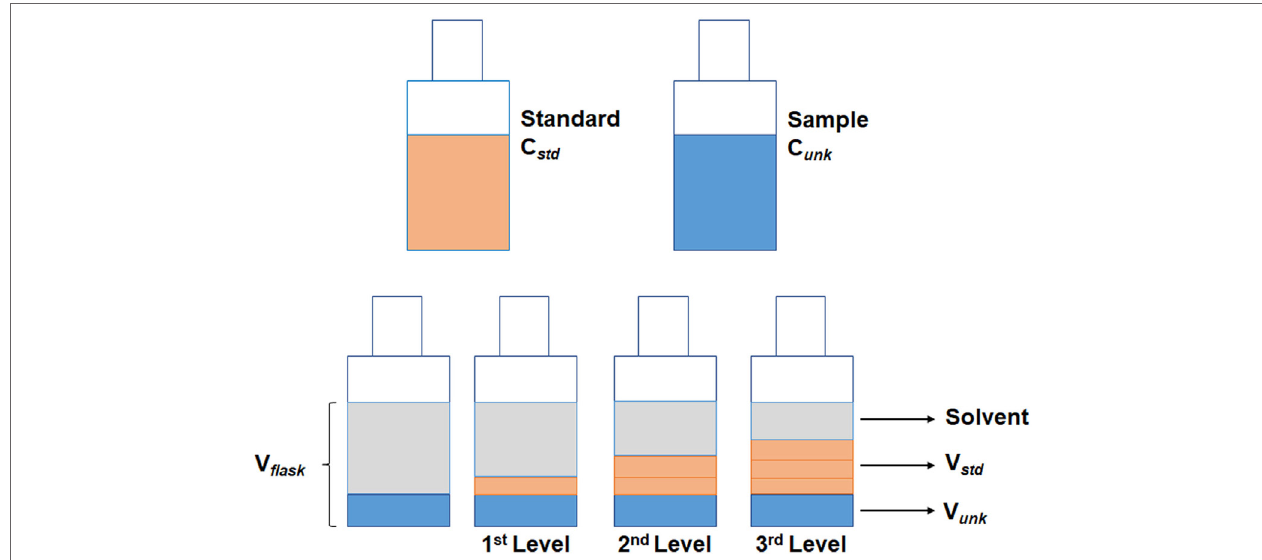
FigUre 1 | Scheme of the solution preparation for the standard addition